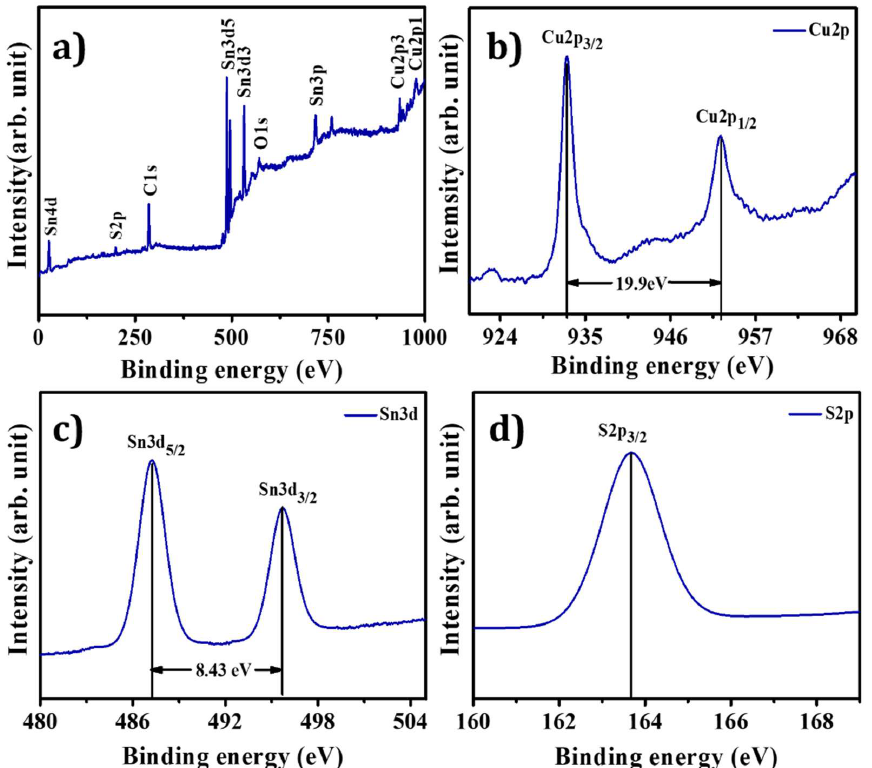
Figure 3. ( a ) Total XPS survey spectrum, ( b ) copper XPS survey spectrum, ( c ) tin XPS survey spec- trum, and ( d ) sulfur XPS survey spectrum of CTS